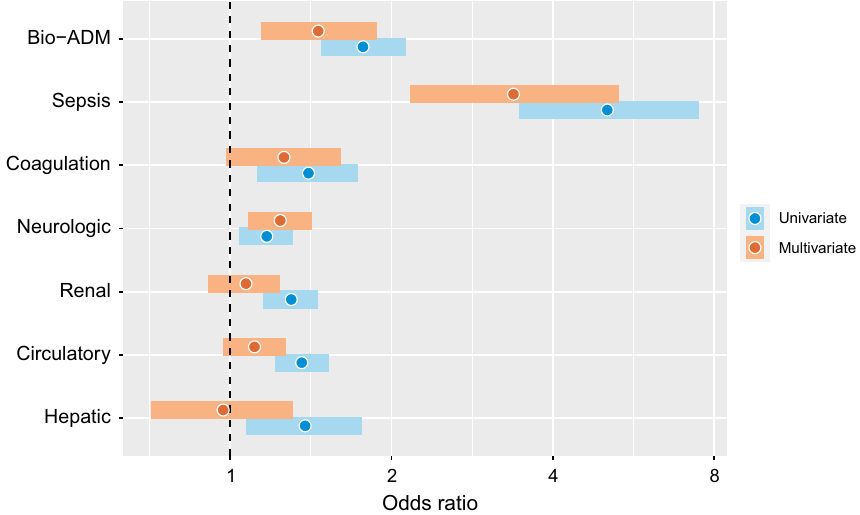
Fig. 3 The association between ARDS, bio-ADM levels, and organ dysfunction as measured by SOFA score on admission with odds ratios (log-2 scale) and 95% confidence intervals from univariate and multivariate logistic regression. Bio-ADM: circulating bioactive adrenomedullin, ARDS: cute respiratory distress syndrome. SOFA: sequential organ failure